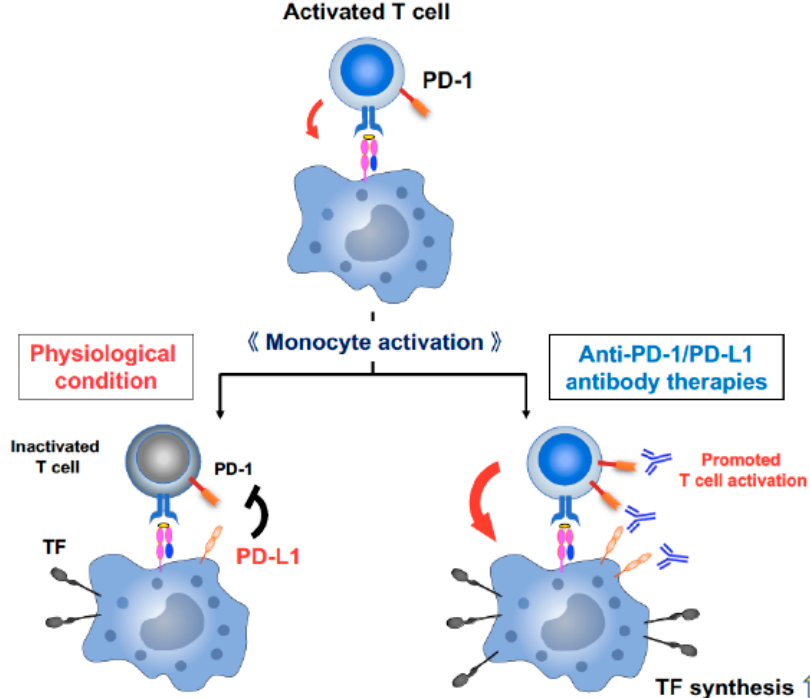
Figure 5. A model demonstrating the association between T cell activation by ICIs and TF production APCs. T cell activation and proliferation are initiated through antigen recognition by the T cell